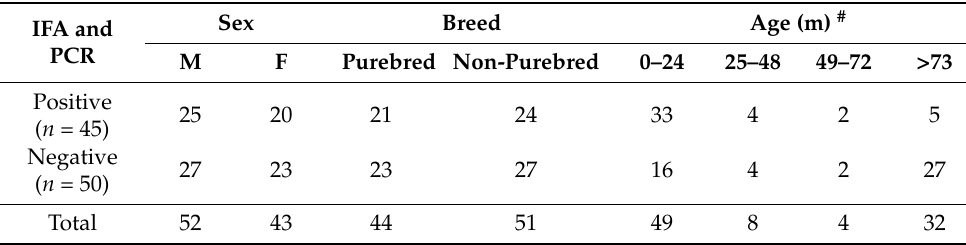
Table 1. Signalment summary of 95 cases in this